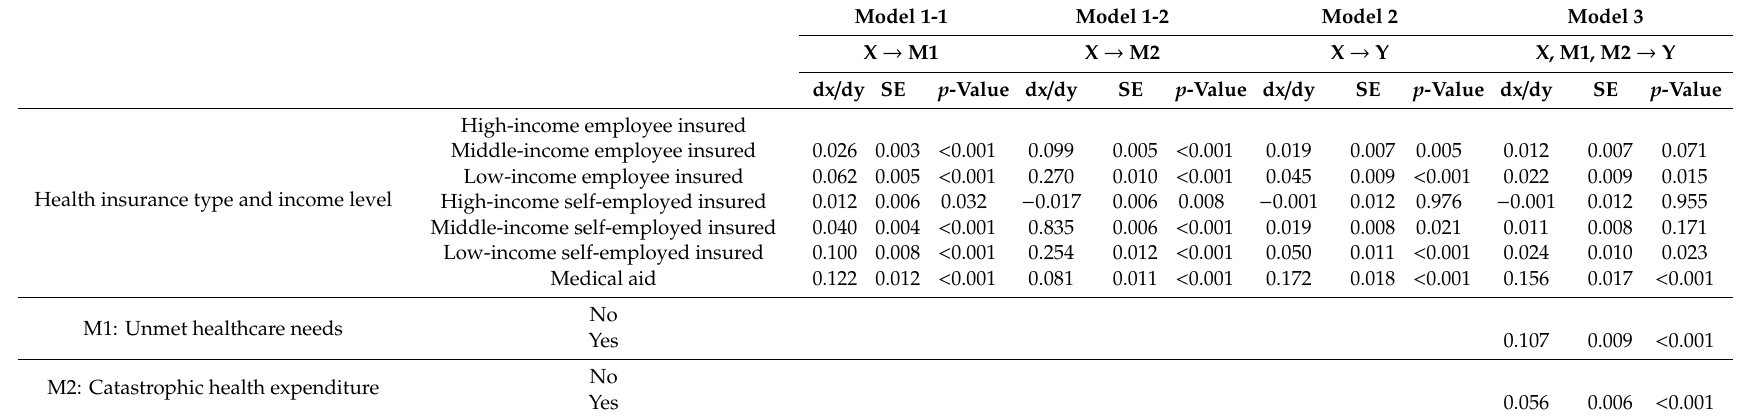
Table 3. E ff ects of catastrophic health expenditure and unmet healthcare needs on health status according to national health insurance type and income